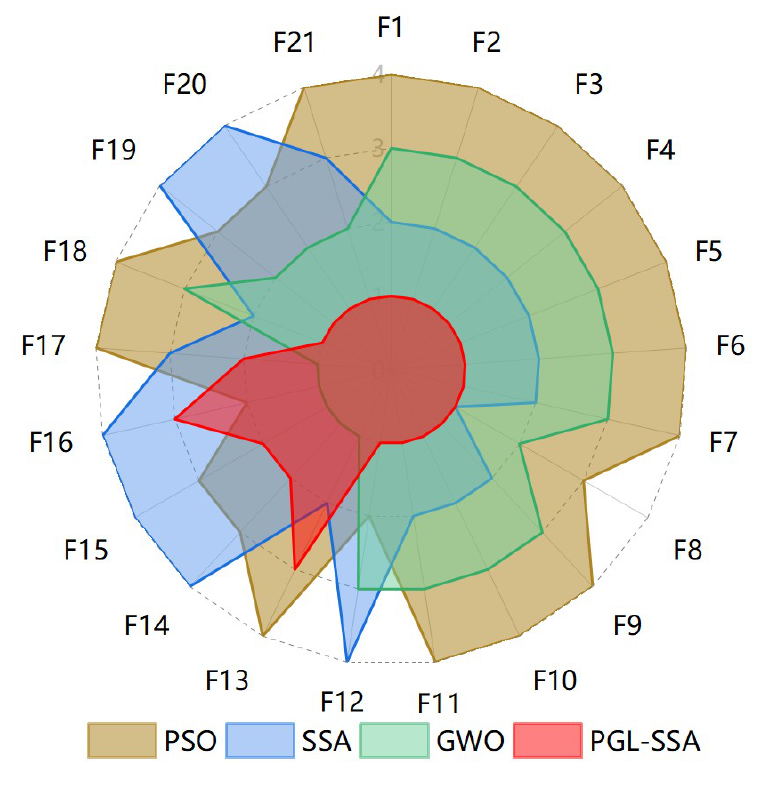
Figure 7. Ranks of 4 algorithms.